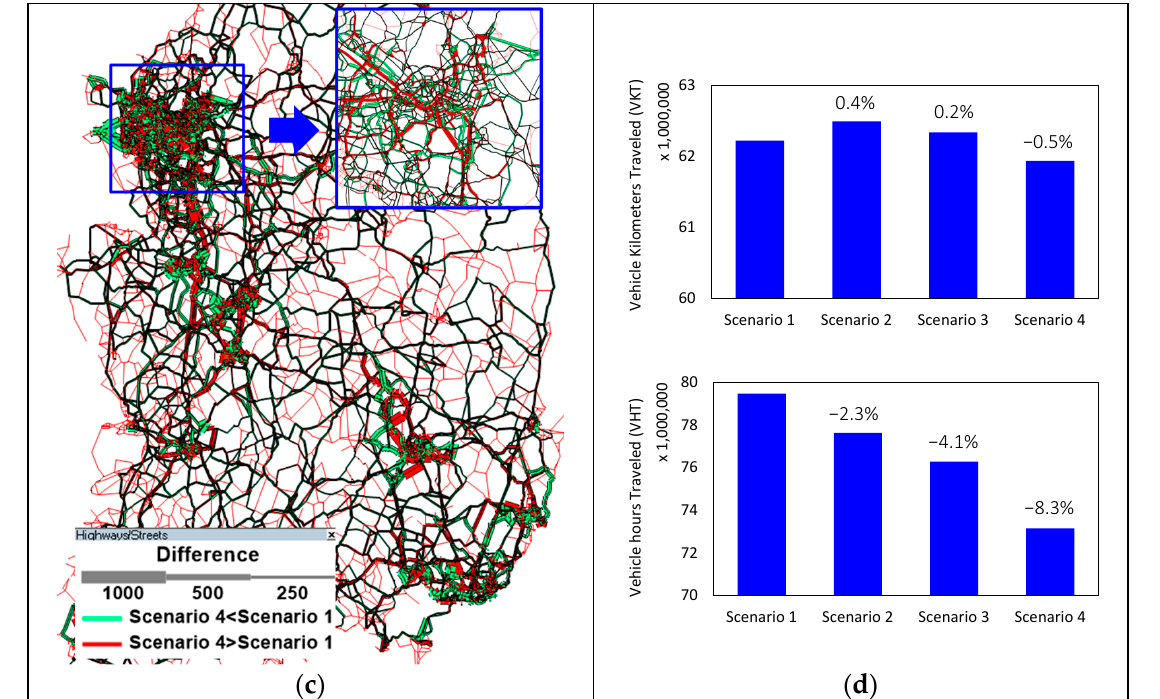
Figure 9. Flow difference between scenario 1 and other scenarios. ( a ) Scenario 1 and scenario 2; ( b ) scenario 1 and scenario 3; ( c ) scenario 1 and scenario 4; ( d ) VKT and VHT for scenarios.